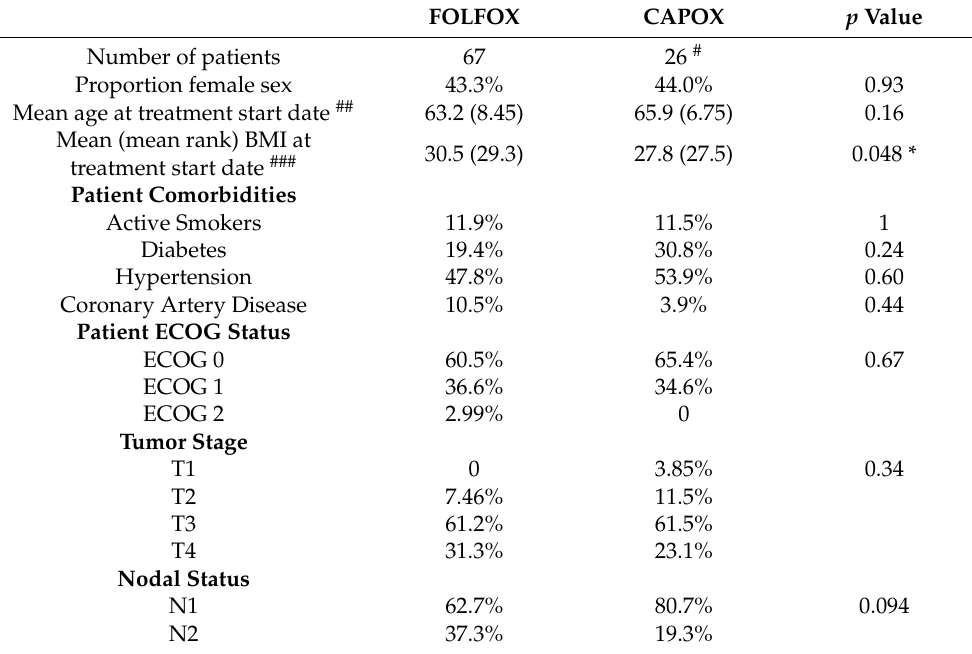
Table 1. Patient Demographics and Comorbidities.